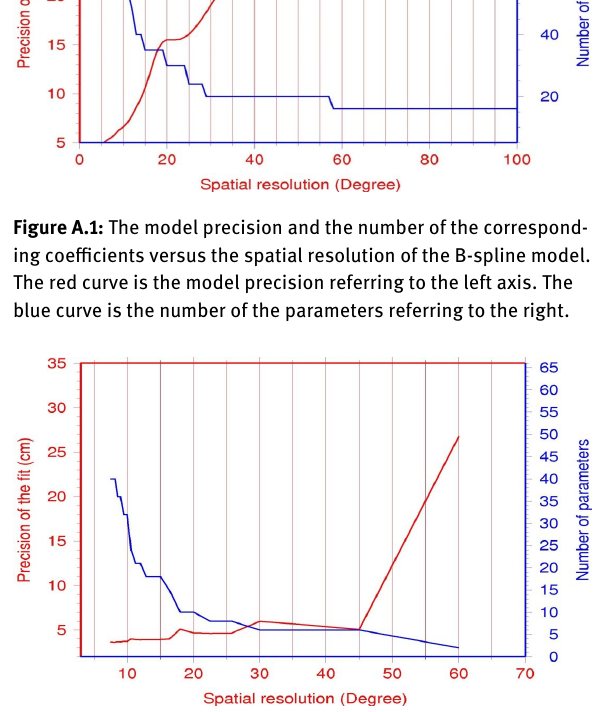
Figure A.2: The model precision and the number of the correspond- ing coefficients versus the spatial resolution of the Legendre poly- nomial model. The red curve is the model precision referring to the left axis. The blue curve is the number of the parameters referring to the